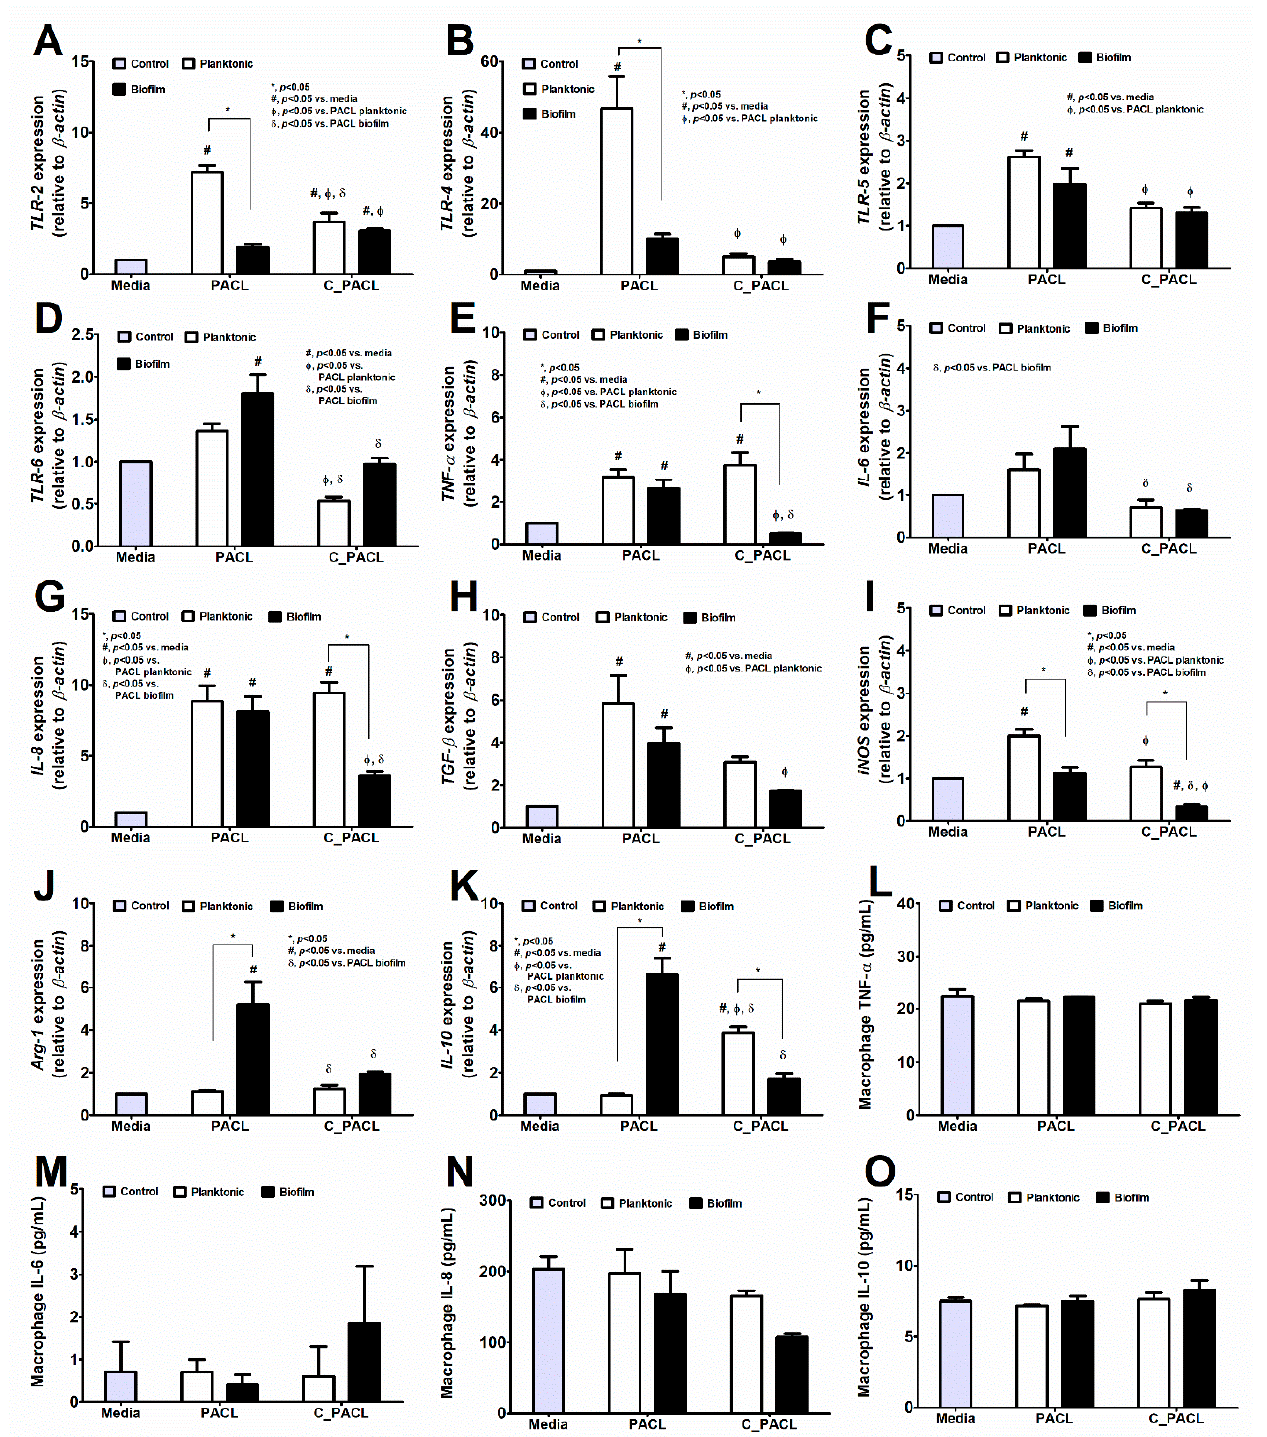
Figure 9. The responses of THP-1-derived macrophage toward P. aeruginosa parent strain (PACL) and Chlorhexidine (CHG)-treated strain (C_PACL) in planktonic (non-biofilms) and sessile (biofilms) forms. The gene expressions by qRT-PCR of TLR-2 , TLR-4 , TLR-5, and TLR-6 ( A – D ), and cytokines ( TNF- α , IL-6 , IL-8 , and TGF- β ) ( E – H ), pro-inflammatory ( iNOS ) ( I ), and anti-inflammatory molecules ( Arg-1 and IL-10 ) ( J , K ) with supernatant cytokines using ELISA (TNF- α , IL-6, IL-8, and IL-10) ( L – O ) are demonstrated. The experiments were performed in independent triplicate. Mean ± SEM are presented with the one-way ANOVA followed by Tukey’s analysis (*, p ˂ 0.05; # , p < 0.05; Φ , p < 0.05; and δ , p < 0.05 considered statistically significant).